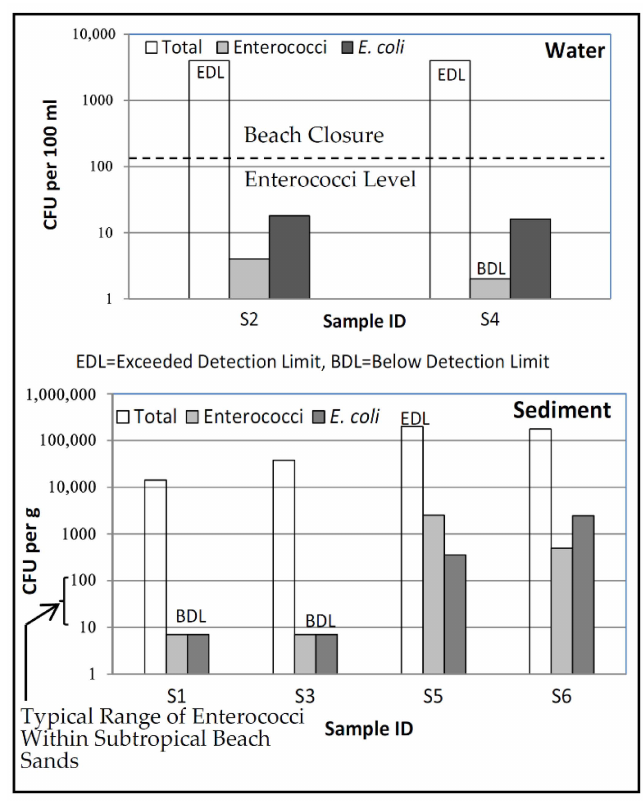
Figure 5. Culturable levels of bacteria from Guánica Bay in water ( above ) and sediment ( below ) samples. (EDL = exceeds detection